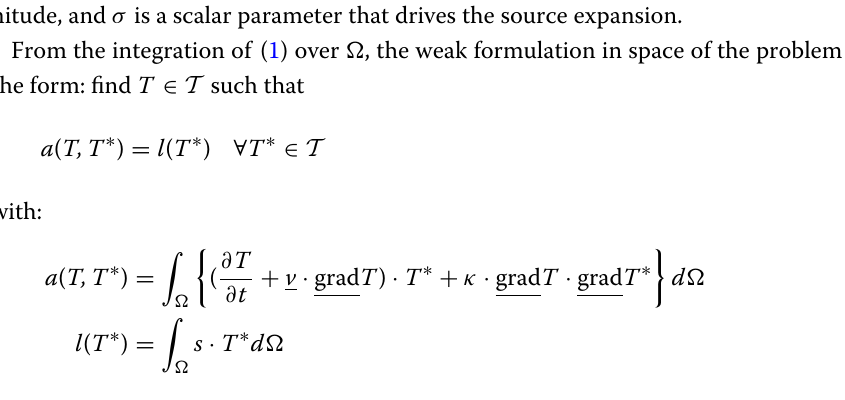
where coordinates ( x c , y c ) represent the location of the heat source center, u is the mag- nitude, and σ is a scalar parameter that drives the source